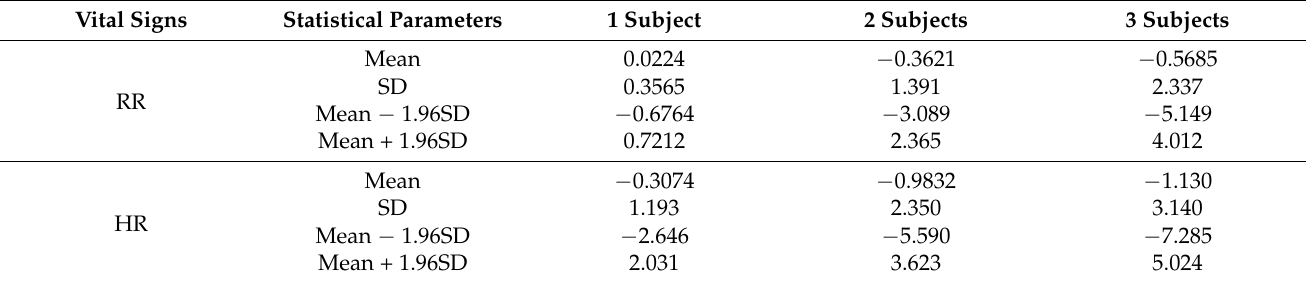
Table 3. Estimation error of RR and HR of different number of subjects (unit of all values is bpm).